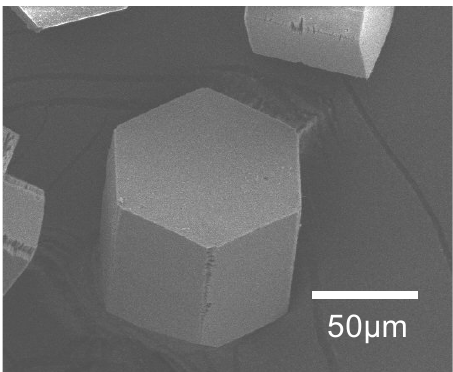
PDC crystals. 2 2